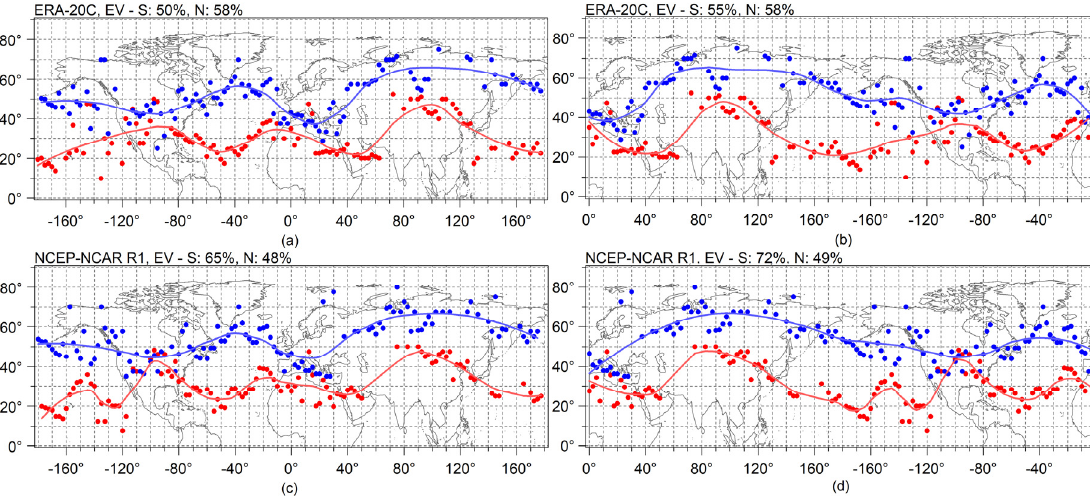
Figure 6. Loess regression curves of the ERA-20C ( a , b ) and the NCEP-NCAR R1 ( c , d ) plotted on maps with the ( a , c ) Atlantic view and ( b , d ) Pacific view. The curves are fitted on the southerly and on the northerly located potential action center (PotAC) poles denoted with blue and red circles, respectively. Explained variance (EV) of loess models in cases of southerly located PotACs (abbreviated as S) and northerly located PotACs (abbreviated with N) are indicated above the maps.